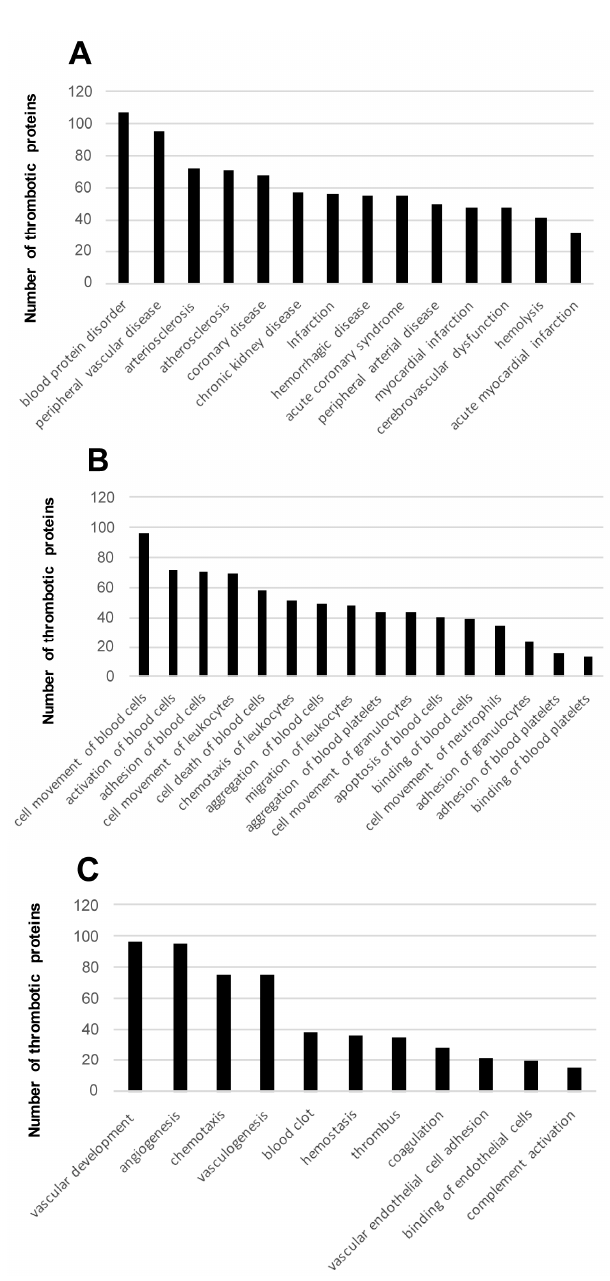
Figure 3. Cardiopathy-related terms ( A ), blood-cell dependent functions ( B ), and peripheral vascular processes ( C ) significantly represented according to the thrombotic proteome characterized in this study (disease and functions from the global 1600 protein list). Table 2. Significantly enriched pathways in our (global) thrombotic proteome dataset.